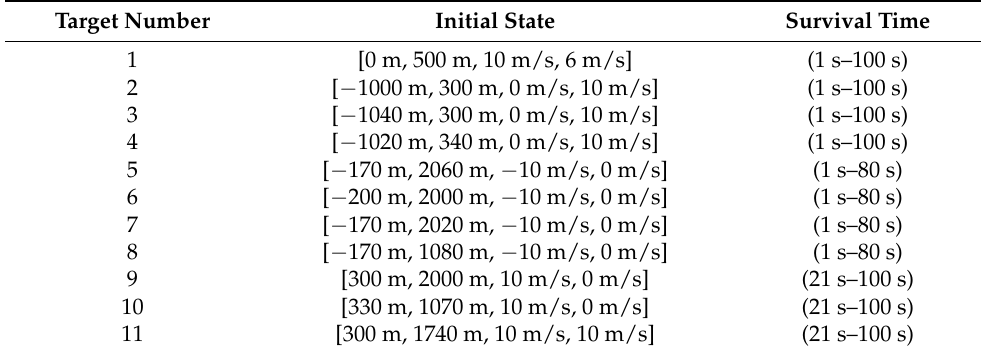
Figure 6. True trajectories of targets. Born/Death positions for each target are marked with ○ / △ . Table 1. The true movement of targets. Table 1. The true movement of